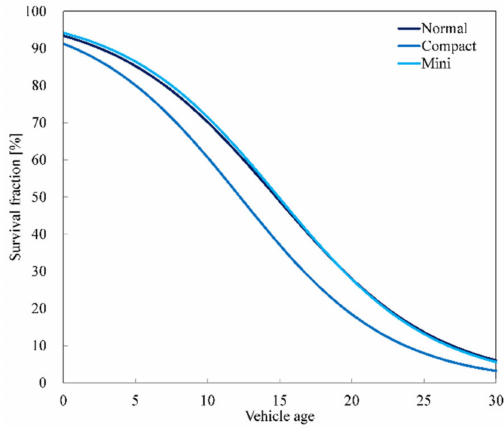
Figure 4. Vehicle survival profiles.